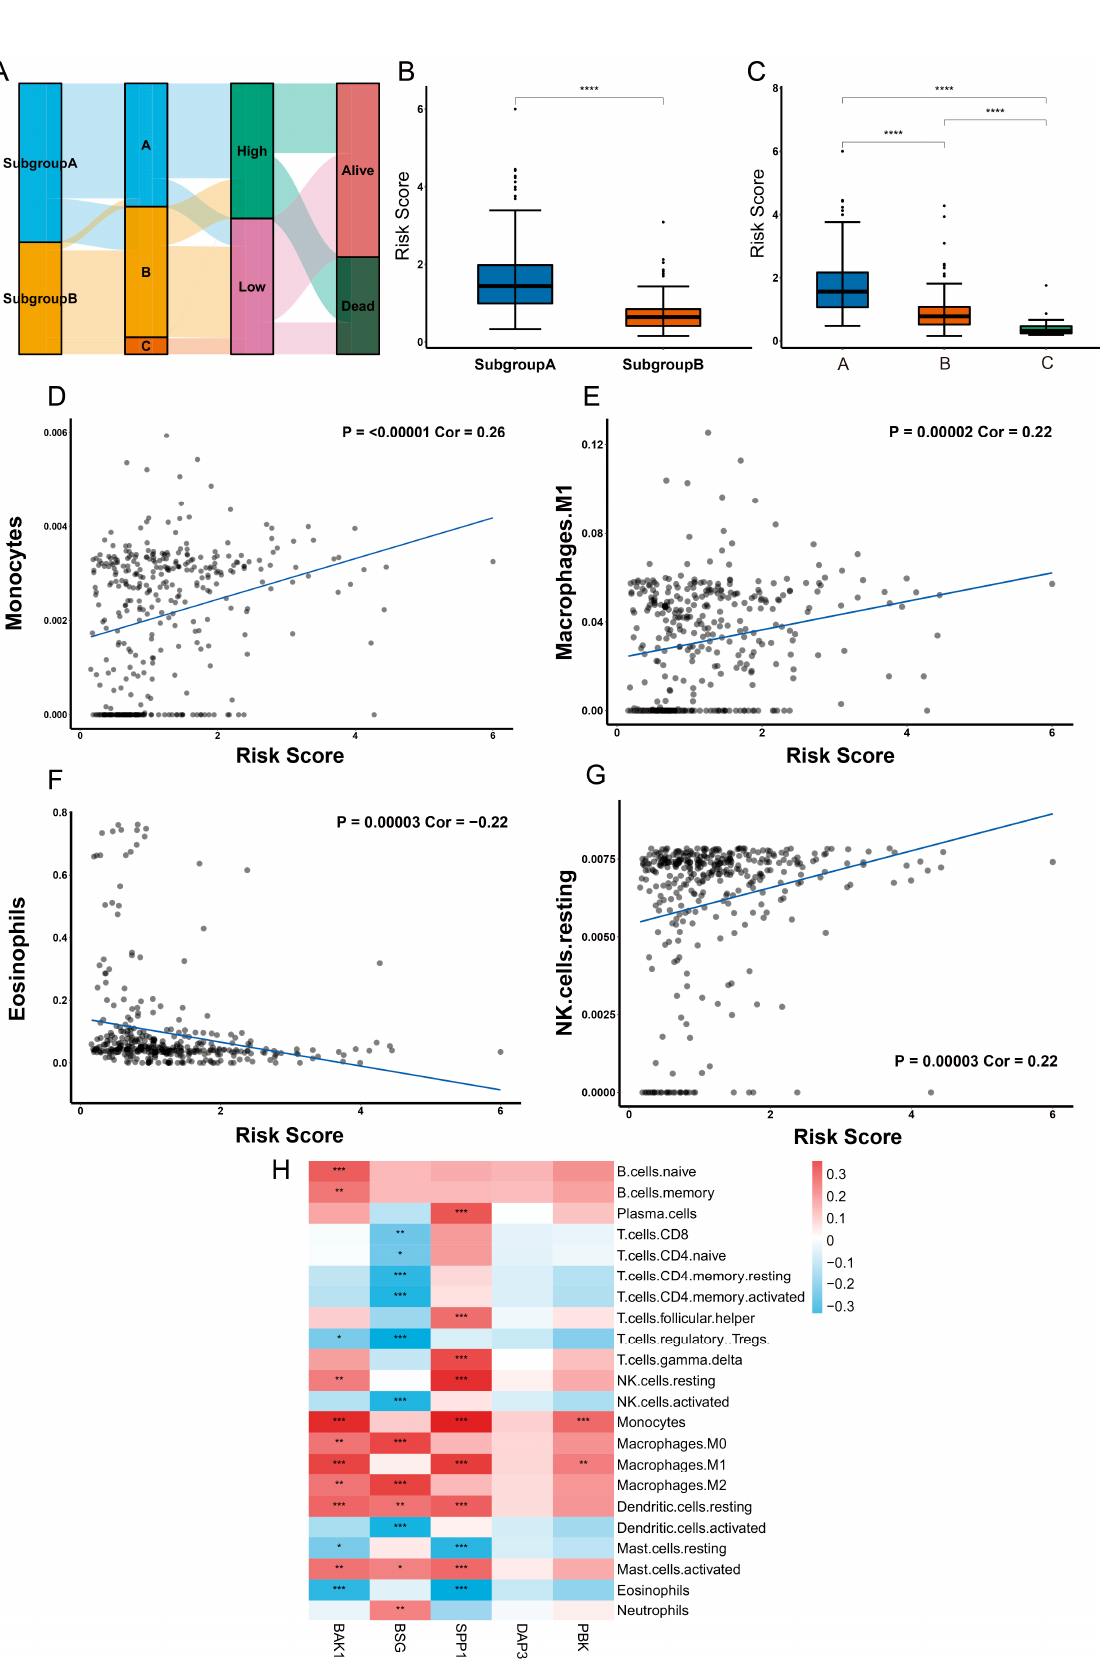
Figure 8. Different characteristics of immune cell infiltration between the two risk groups. ( A ) Sankey diagram of the two subgroups, three gene clusters, two risk groups and two clinical